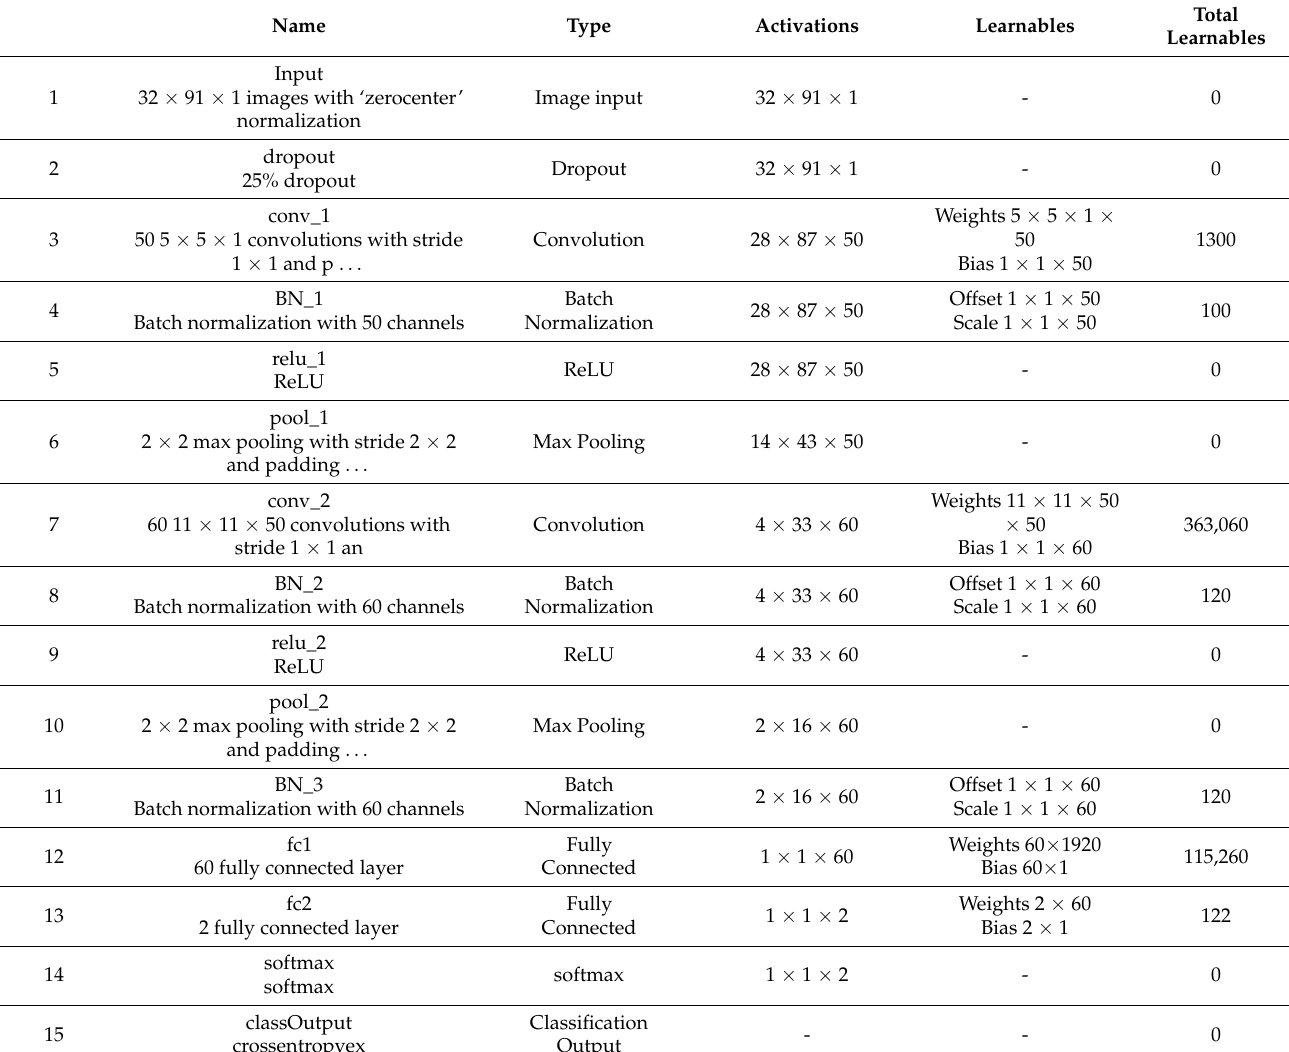
Table 3. CNN model specifications of the CNNeeg1-1